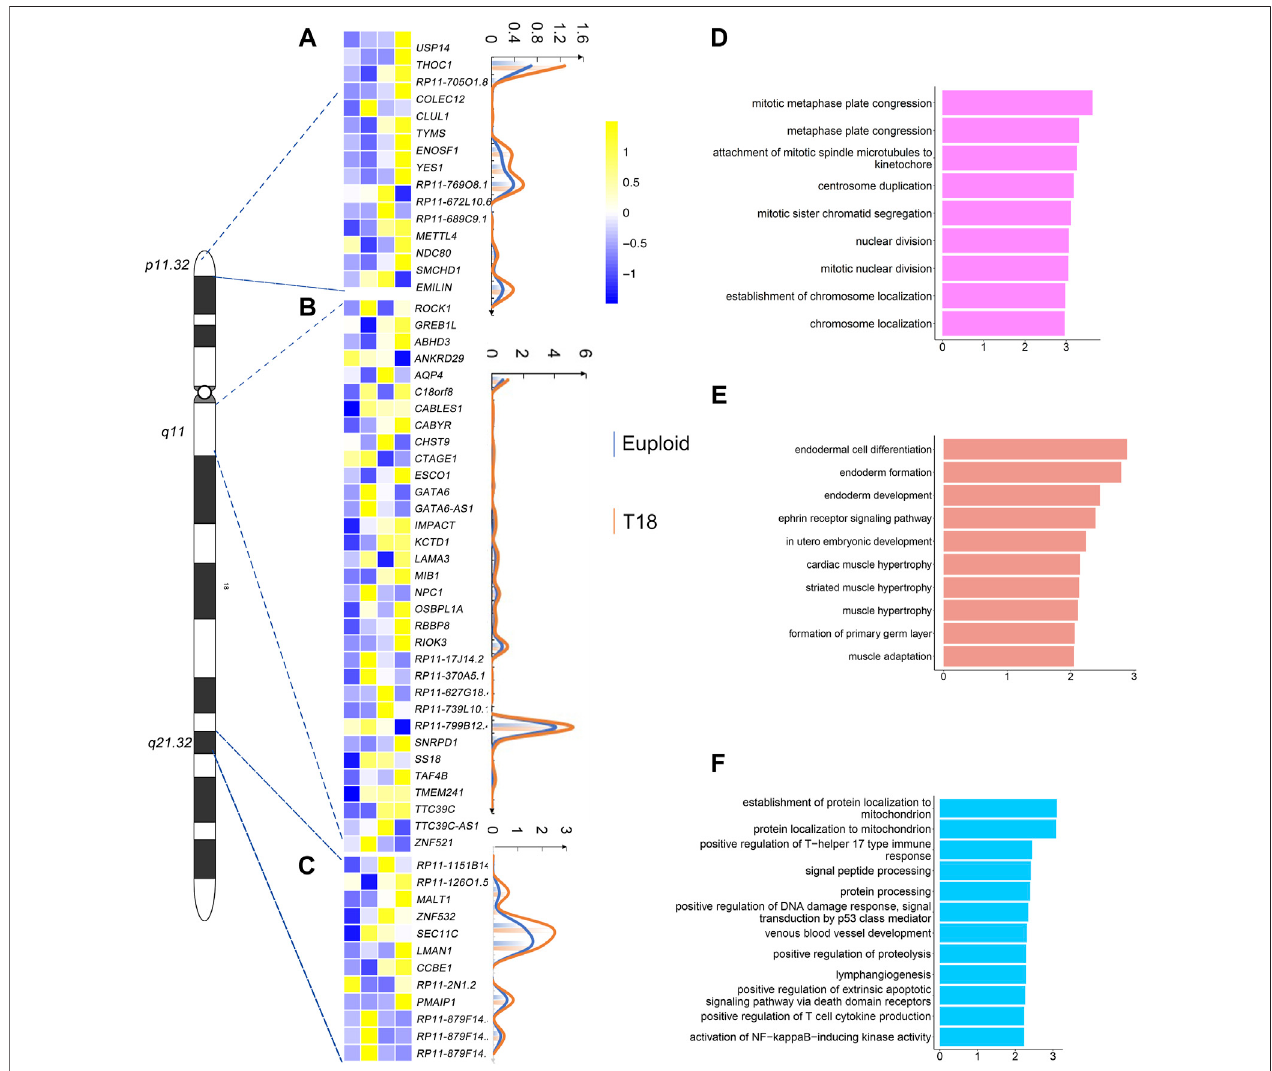
FIGURE5| Geneexpression analysesin18p11.32, 18q11and18q11.32 regions. (A) Heatmapofdifferentially expressed genes( p ≤ 0.01)inthe18p11.32region from twoeuploid and threetrisomy18samples.Uniquemolecularidenti fi ers (UMIs)counts ofdifferentially expressed genesineuploid (blueline)and trisomy 18samples (orangeline). (B) Heatmap ofdifferentially expressedgenes( p ≤ 0.01)inthe18q11region.UMIscountsofdifferentiallyexpressed genesineuploid(blueline)andtrisomy 18 samples (orange line). (C) Heatmap of differentially expressed genes ( p ≤ 0.01) in the18q21.32 region. UMIs counts of differentially expressed genes in euploid (blue line) and trisomy 18 samples (orange line). (D – F) Top gene ontology (GO) terms of differentially expressed genes in the 18q11.32 (D) , 18p11 (E) and 18q21.32 (F) regions.